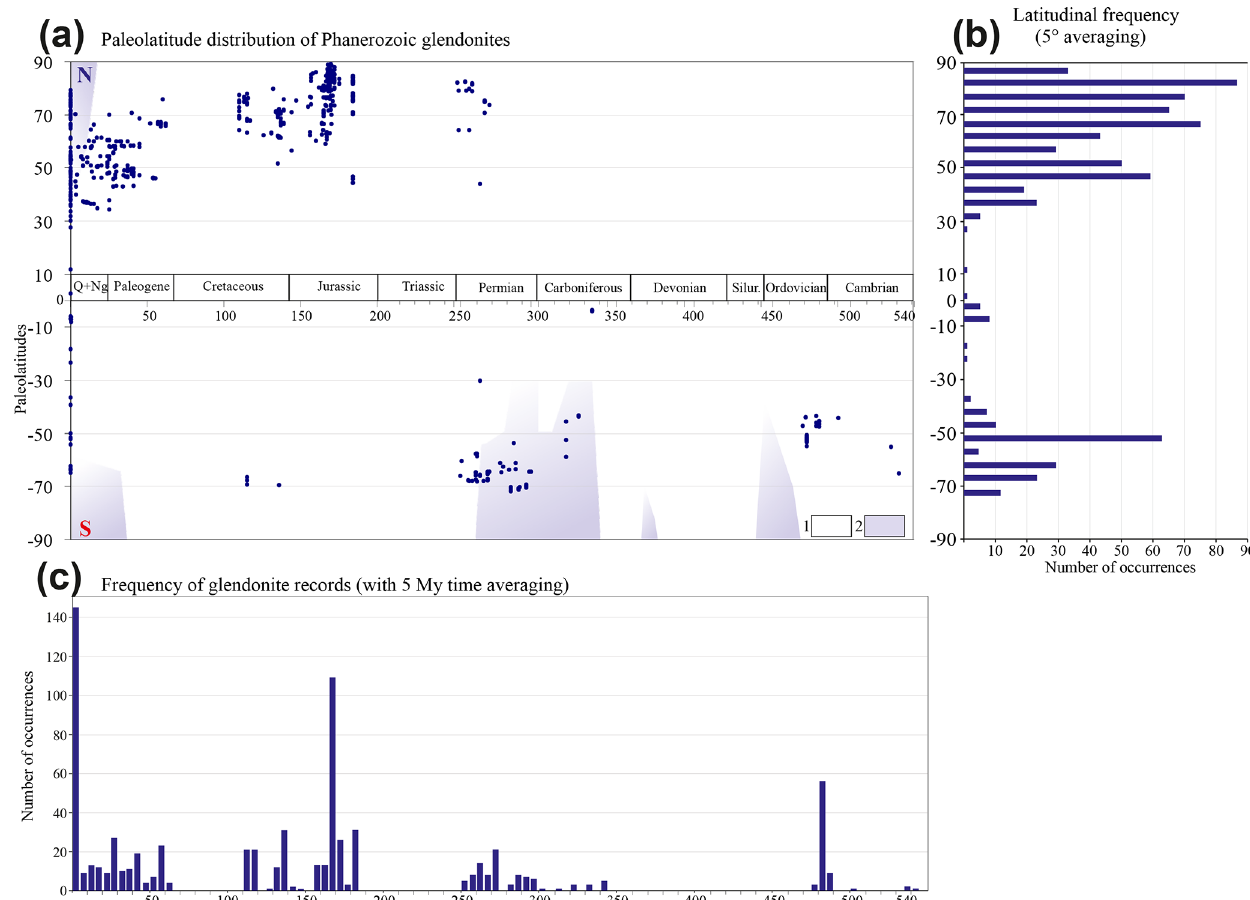
Figure 5. Paleolatitudinal distribution of glendonite and ikaite records through time. (a) Paleolatitudinal occurrence; 1 – non-glacial intervals, 2 – glaciations (after Frakes et al., 2005); (b) latitudinal frequency of glendonite occurrences (with 5 ◦ averaging); (c) frequency of glendonite occurrence through time (with 5Myr